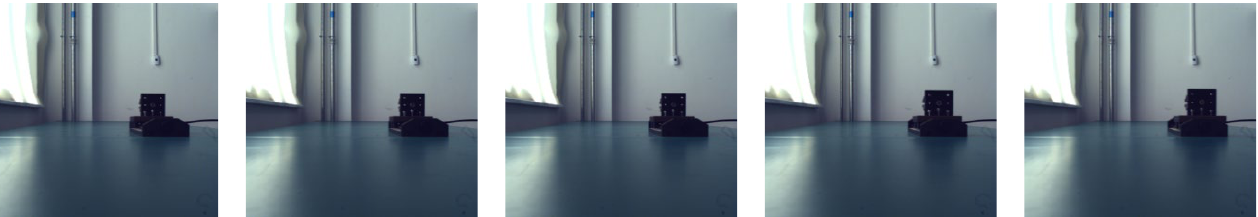
Figure 12. Left view of solid motion image acquisition.